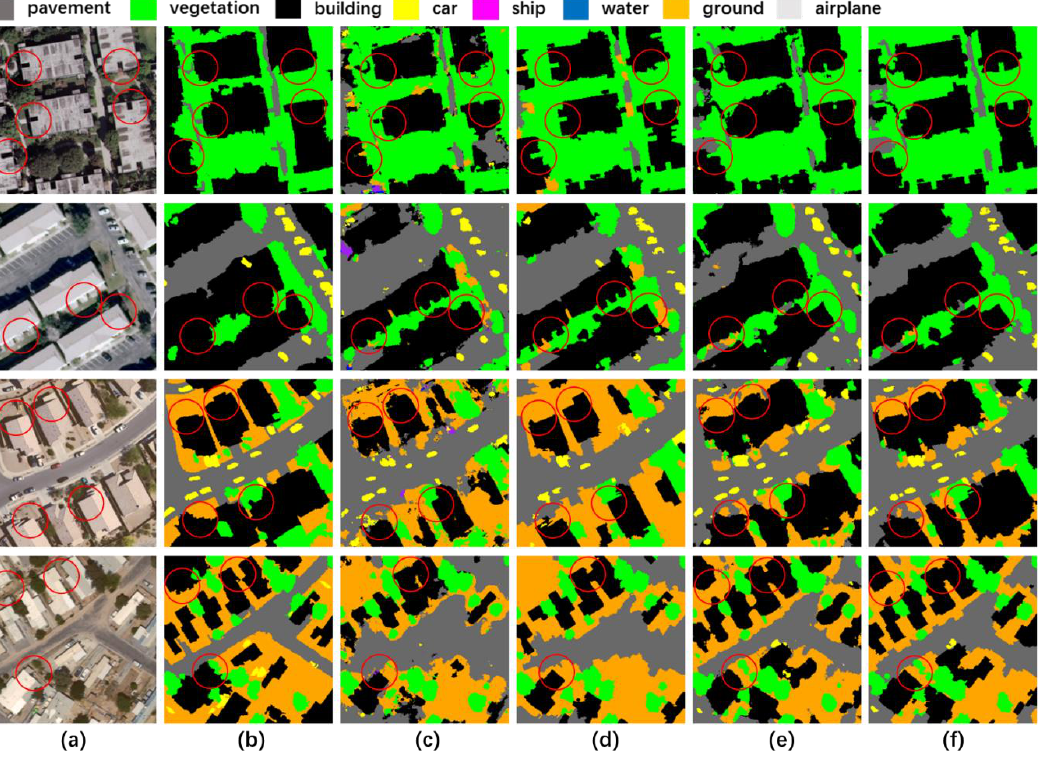
Figure 12. The results of segmentation. ( a ) Raw image, ( b ) ground truth, ( c ) results of U-Net, ( d ) results of DSSN-GCN V1, ( e ) results of the proposed AttResUNet and ( f ) results of AttResUNet-GCN (DSSN-GCN V4).